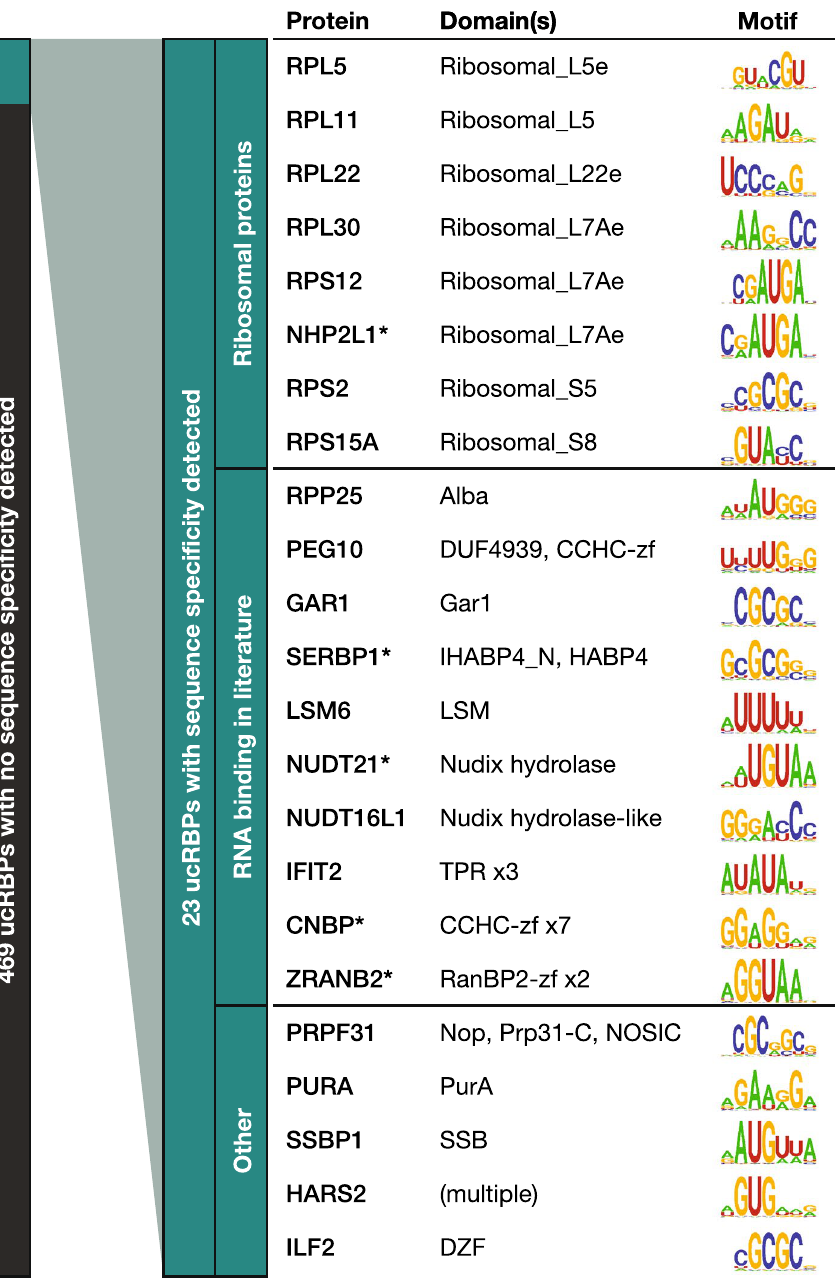
Figure 2. Large-scale analysis of intrinsic ucRBP RNA-binding specificity. A total of 23 sequence-specific ucRBPs were discovered among a panel of 492 and grouped into three classes: “Ribosomal proteins”, those associated with “RNA-binding in the literature”, and “Other,” which likely represent new sequence-specific ucRBPs. ucRBP gene names, corresponding protein domains, and RNAcompete-derived motif logos are